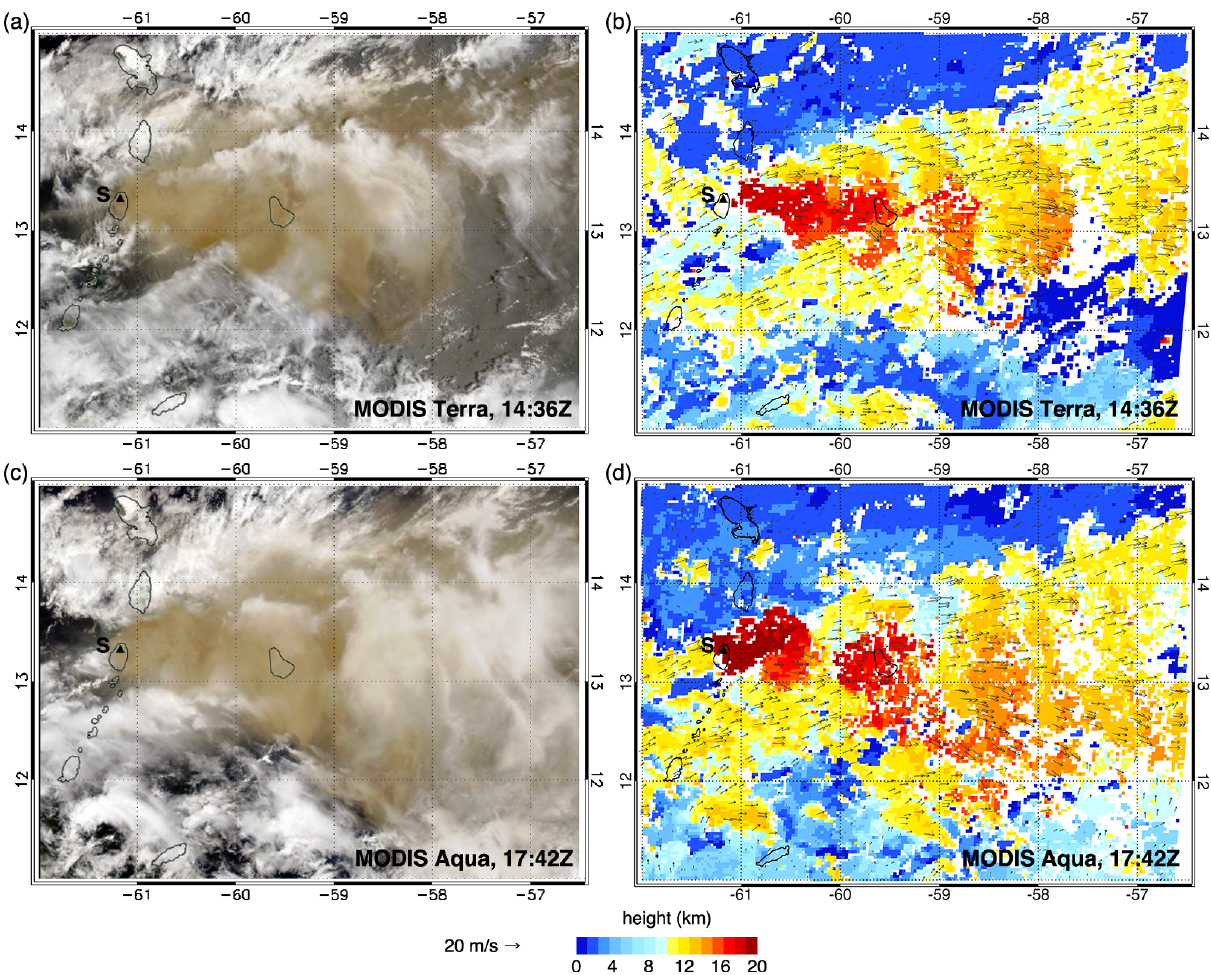
Figure 14. True color images of the plume on 10 April 2021 by (a) MODIS Terra (14:36UTC) and (c) MODIS Aqua (17:42UTC). The corresponding GOES-16–MODIS 3D Winds stereo heights are plotted in panels (b) and (d) , with motion vectors shown for a random 5% of retrievals. La Soufrière is marked by the black triangle and letter